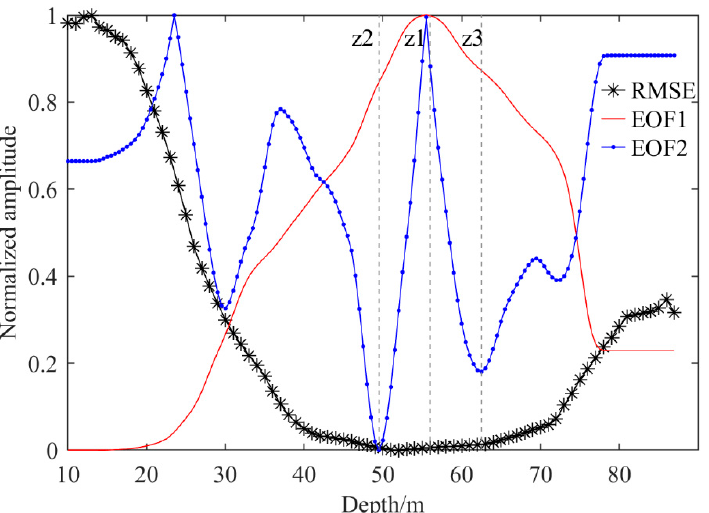
Figure 9. Mean RMSE of test set temperature profiles reconstructed from temperatures at a certain depth (denoted as black stars). The red line is the normalized first EOF; the blue line is the normalized absolute value of the second EOF, and the three gray dotted lines represents the depth z 1 , z 2 , z 3 ,